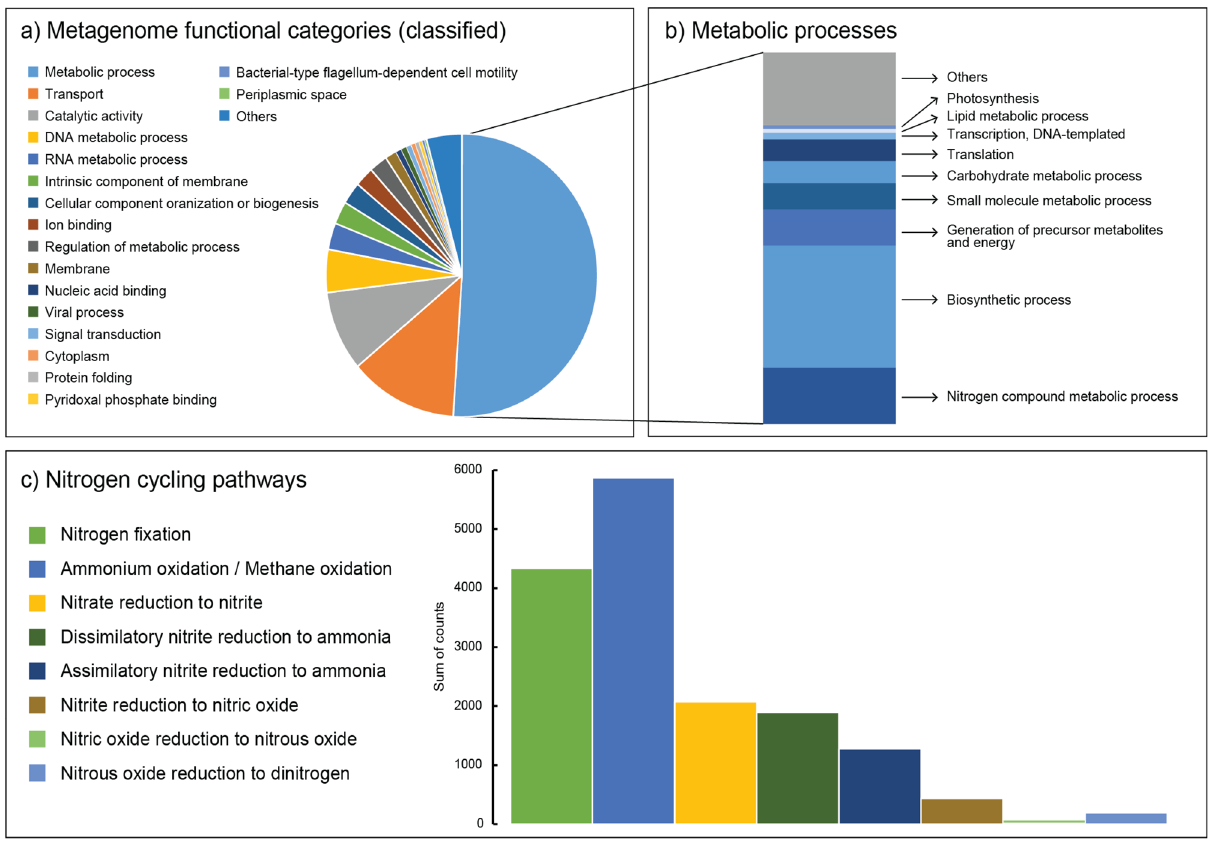
Figure 2. Functional profiling of the crab’s carapace microbiota using metagenomics: ( a ) Gene Ontology functional categories of metagenome sequences (%) that constituted the majority of the metagenomic data (45.3% classified reads) with ( b ) a breakdown of the subcategories (%) among the classified metabolic processes and ( c ) metabolic processes of the nitrogen cycle (5% of the “Nitrogen compound metabolic process” subcategory). Pathways consist of the sum of counts for related proteins. The analysis was limited to functional categories >